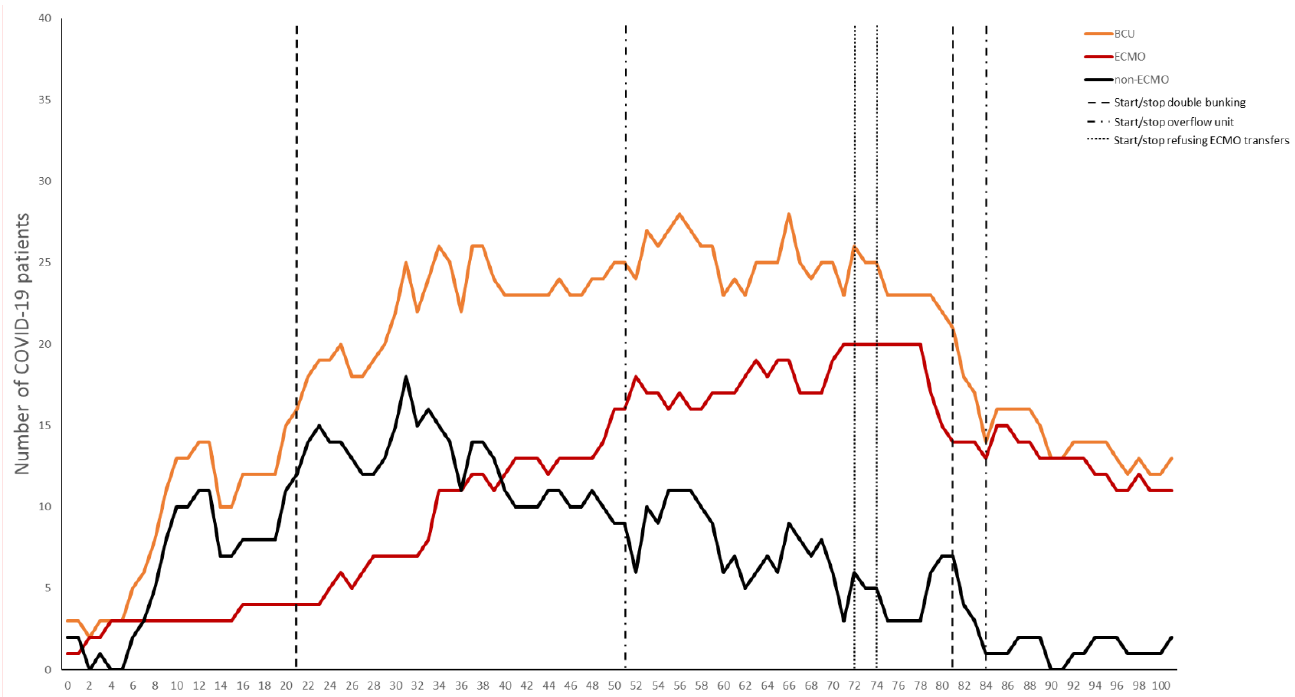
Figure 4. Total patients in the biocontainment unit and number of ECMO versus non-ECMO patients over time.